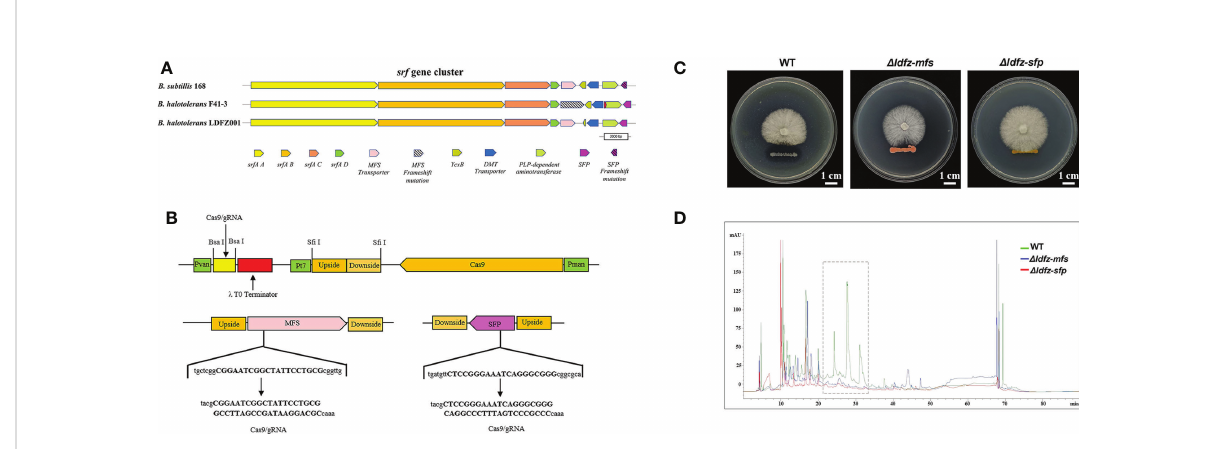
FIGURE 5 Functional analysis of SFP and MFS transporter genes. (A) Comparison of core genes in the srf gene clusters from B halotolerans LDFZ001, B subtillis 168 and B halotolerans F41-3. (B) A schematic map to show the gRNA sequence positions of SFP e and MFS genes. (C) D ldfz - sfp and D ldfz - mfs generated by respectively editing the SFP and MFS in B halotolerans LDFZ001 led to the loss of antifungal activity. (D) HPLC pro fi le of lipopeptide extracts from WT and mutant D ldfz - sfp and D ldfz - mf .